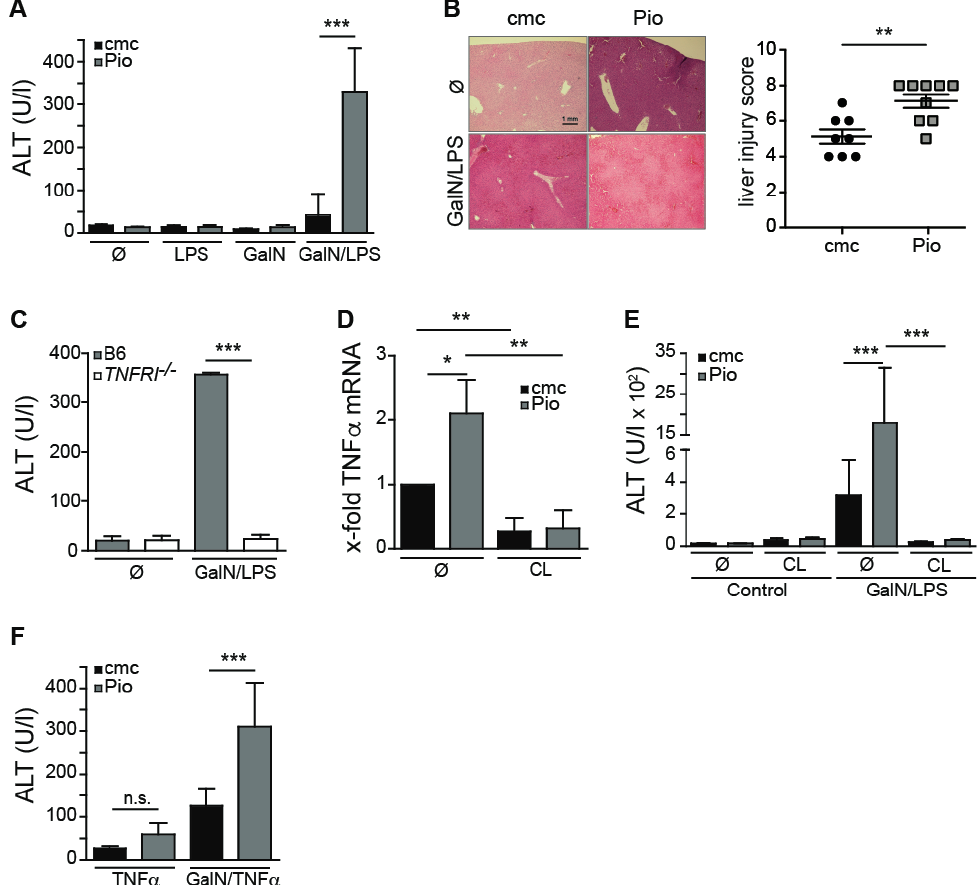
Figure 3. Oral administration of Pioglitazone sensitizes mice for immune-mediated experimental hepatitis. ( A , B , D , E , F ) C57BL / 6 and ( C ) TNF receptor I (TNFRI) − / − mice were fed with 30 mg / kg Pioglitazone or with vehicle (cmc) for 7 days. ( A ) Plasma ALT levels from C57BL / 6 mice after 6–7 h after the i.p. injection of GalN, LPS, GalN/LPS or phospate buffered saline (PBS). ( B ) Exemplary H&E staining of livers of as-indicated at 20 × magnification. The bar graph depicts a histological liver injury score as detailed in the Materials and Method Section of vehicle ( n = 7) and vehicle + Pioglitazone ( n = 9)-treated mice. ( C ) Plasma ALT levels 6–7 h after i.p. GalN / LPS or PBS injection into C57BL / 6 and TNFRI − / − mice that were fed with Pio for 7 days. ( D ) C57BL / 6 mice that were fed with Pio or vehicle (cmc) for 7 days were injected with clodronate liposomes (CL) or were left untreated. Then, mice received GalN / LPS i.p. and 1 h later, intrahepatic TNF α mRNA levels were determined by real-time polymerase chain reaction (PCR). ( E ) Plasma ALT levels were determined 6–7 h after injection of GalN / LPS in clodronate liposome (CL)-injected and non-injected C57BL / 6 mice. ( F ) Pio- and vehicle-fed C57BL / 6 mice were injected with 400 ng TNF α 30 min post GalN injection or received GalN alone. Plasma ALT levels were measured 4 h later. Error bars indicate mean ± SD, n ≥ 4; one